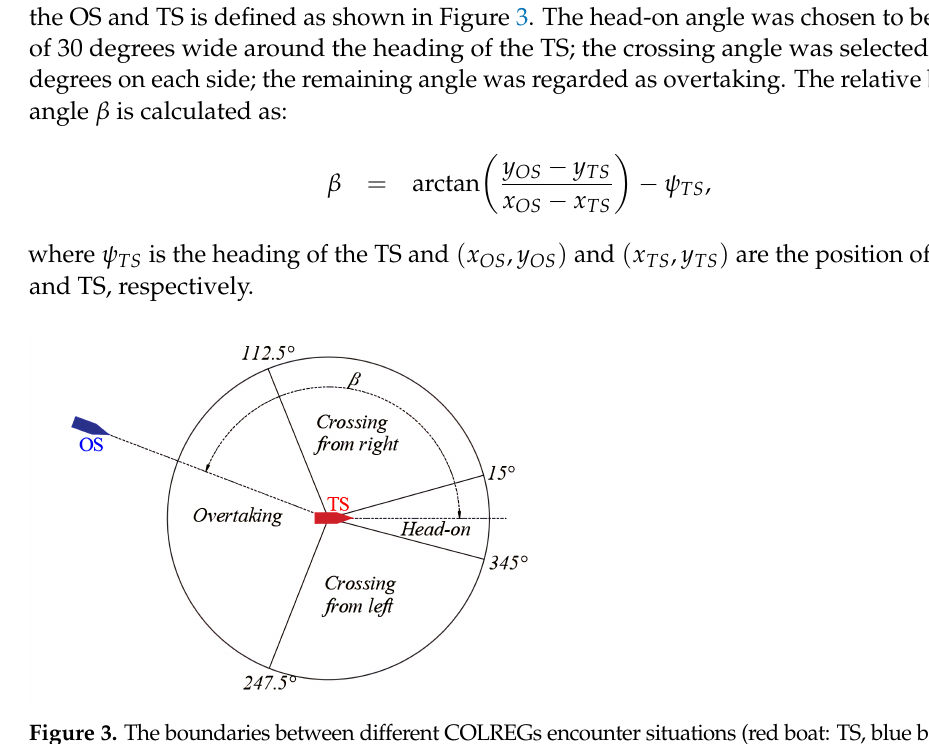
Figure 3. The boundaries between different COLREGs encounter situations (red boat: TS, blue boat: